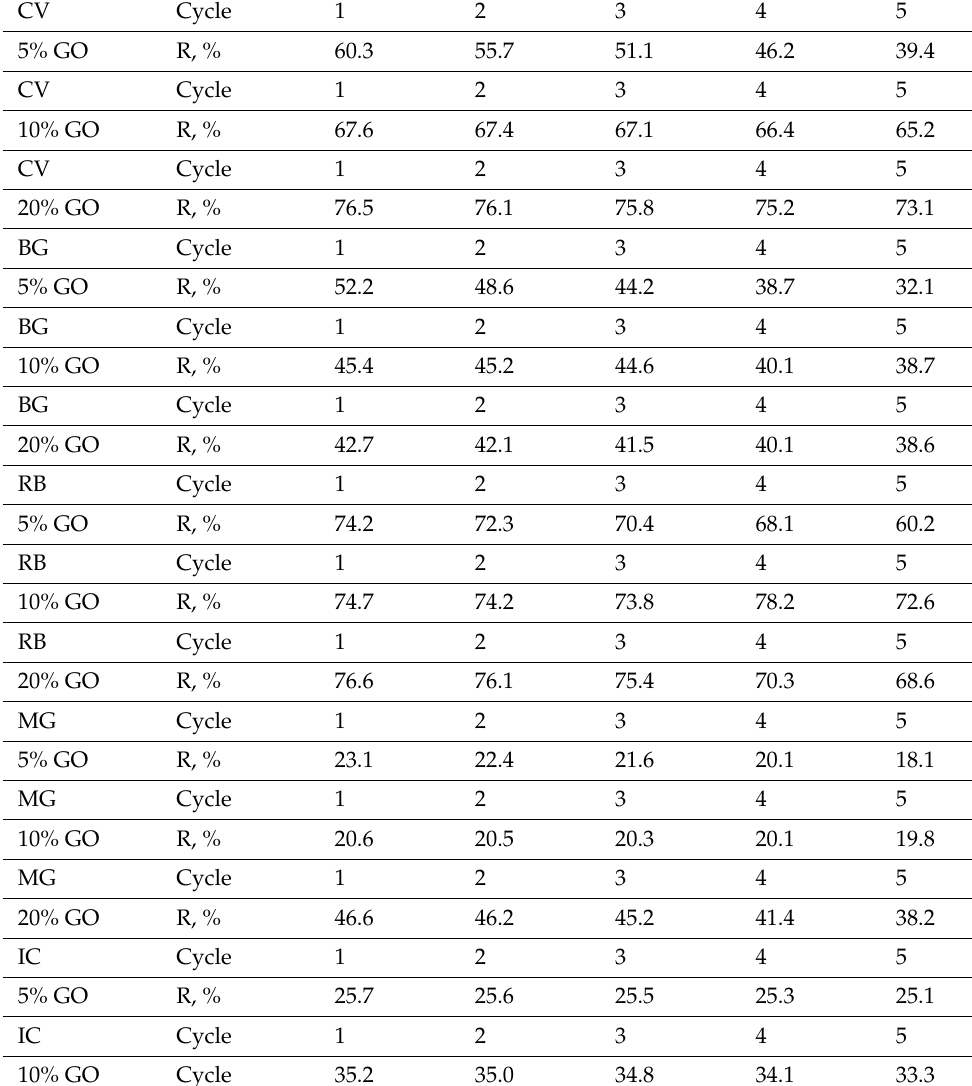
Table 7. Dependence of the degree of extraction on the number of working